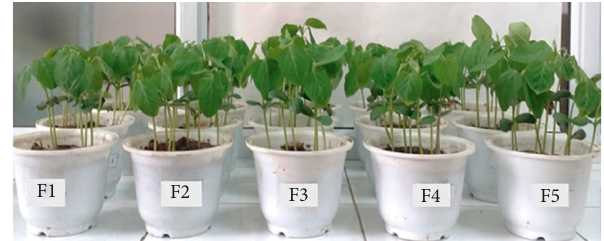
Figure 5: Soybean seedlings grown with formulations of different nutrient compositions 7days after sowing. Table 5: Enzymatic activity of the soybean seeds treated with different nutrient formulations (triple experiment). Enzymatic activity (IU/g) Enzymes Formulations Experiment 1 Experiment 2 Experiment 3